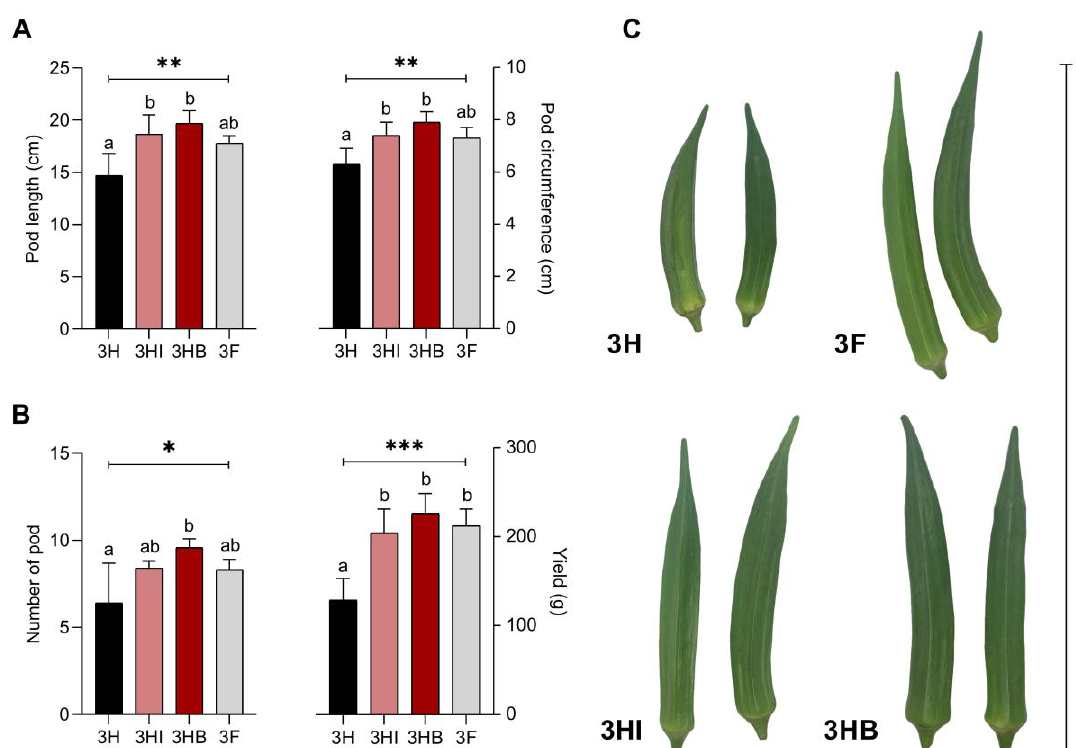
Figure 3. Effect of free-cell and encapsulated E. hormaechei 40a on okra yield after 60 days grown under greenhouse conditions. ( A ): pod length and circumference; ( B ): number of pods and yield; ( C ): okra pods. Data (mean ± standard deviation, n = 4) followed by different letters between treatments indicate significant differences (one-way ANOVA + Tukey multiple comparisons test at p ≤ 0.05). p -value summary: ns, >0.05; *, <0.05; **, <0.01; ***, <0.001; ****, <0.0001. Half-dose PK-fertilizer, 3H; half-dose PK-fertilizer and free-cell strain 40a, 3HI; half-dose PK-fertilizer and encapsulated strain 40a, 3HB; full-dose PK-fertilizer, 3F.